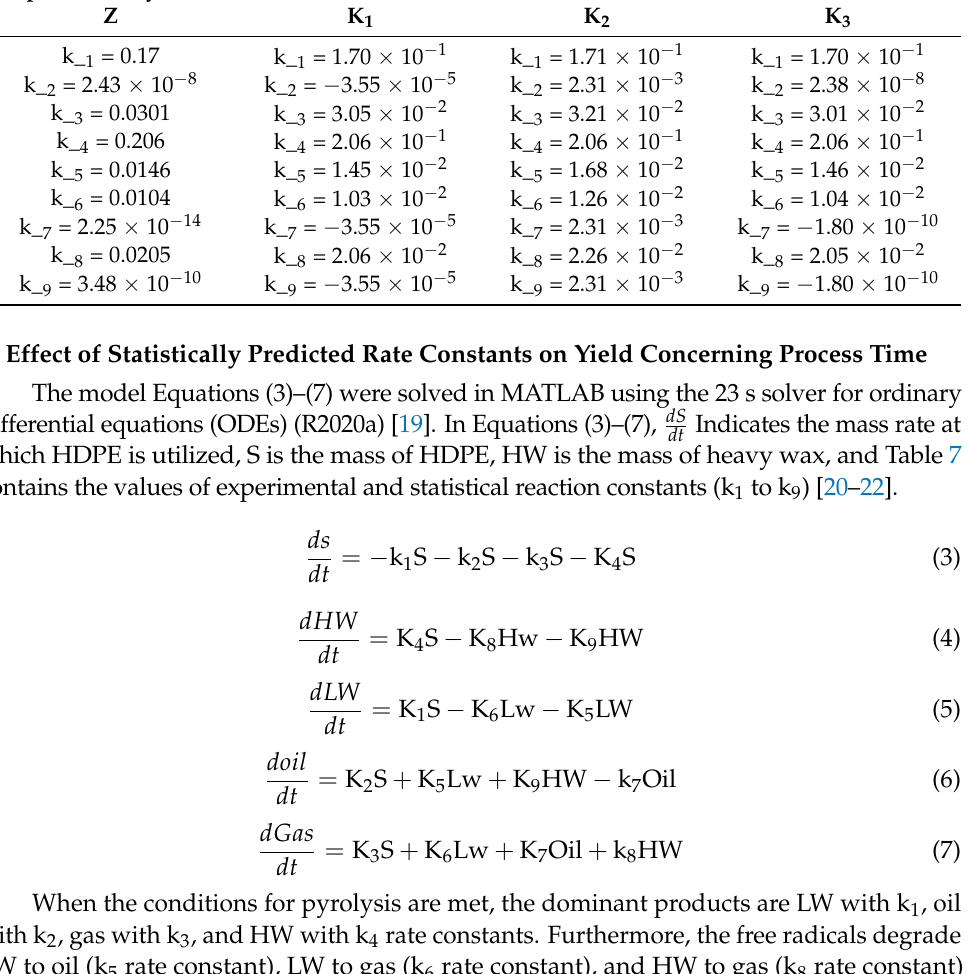
Table 7. Both experimentally fixed and statistically estimated rate constants for pyrolysis of HDPE. Experimentally